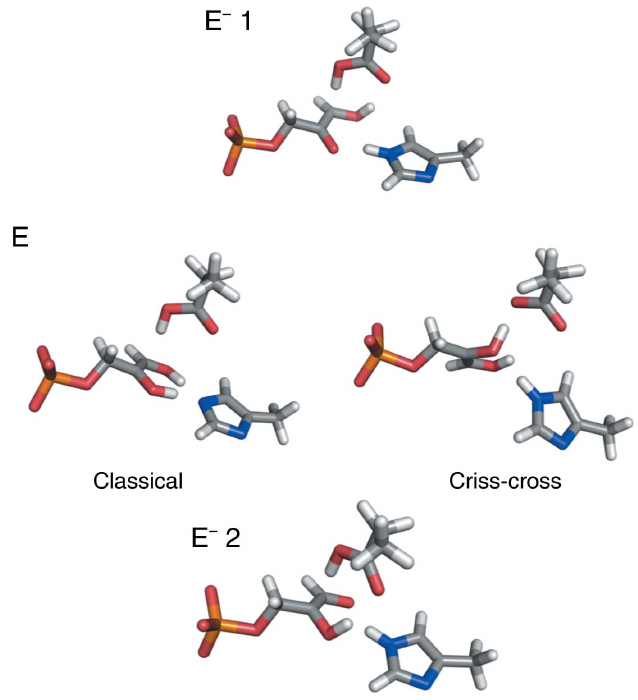
Figure 9 The three intermediates in the mechanism of TIM isomerization. E (cid:5) 1, enediolate intermediate 1; E, enediol intermediate; E – 2, enediolate intermediate 2. The shuffle mechanism has no enediol intermediate.